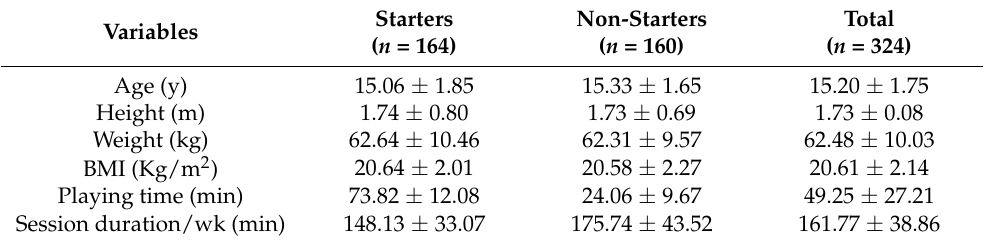
Table 1. Description of the participants’ subsamples according to the player’s starting status. Starters Variables ( n =